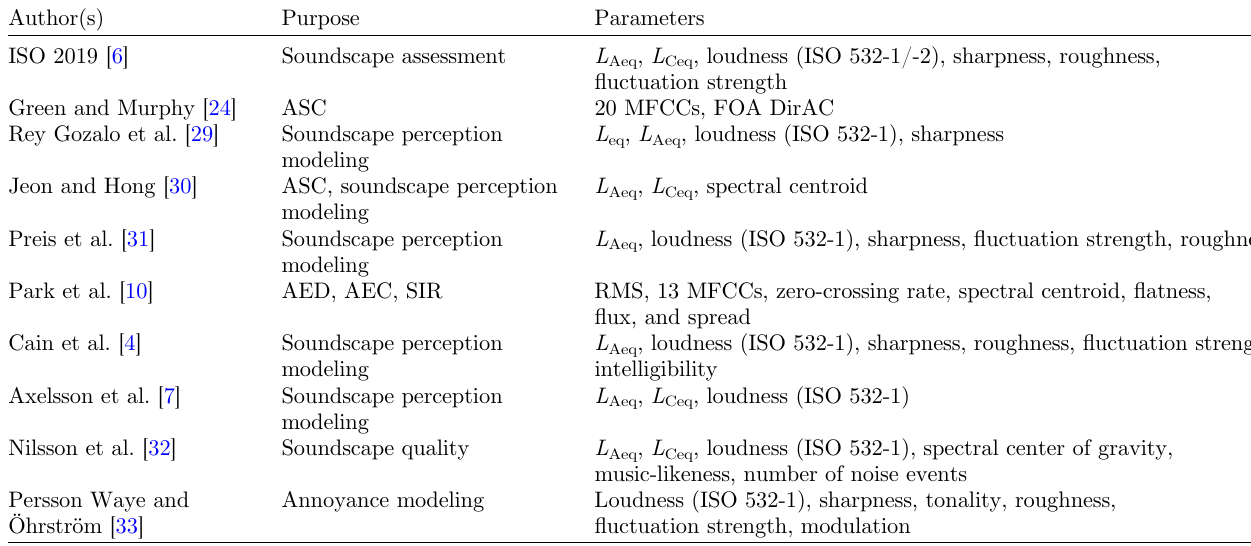
Table 1. Exemplary overview on research using different sets of signal